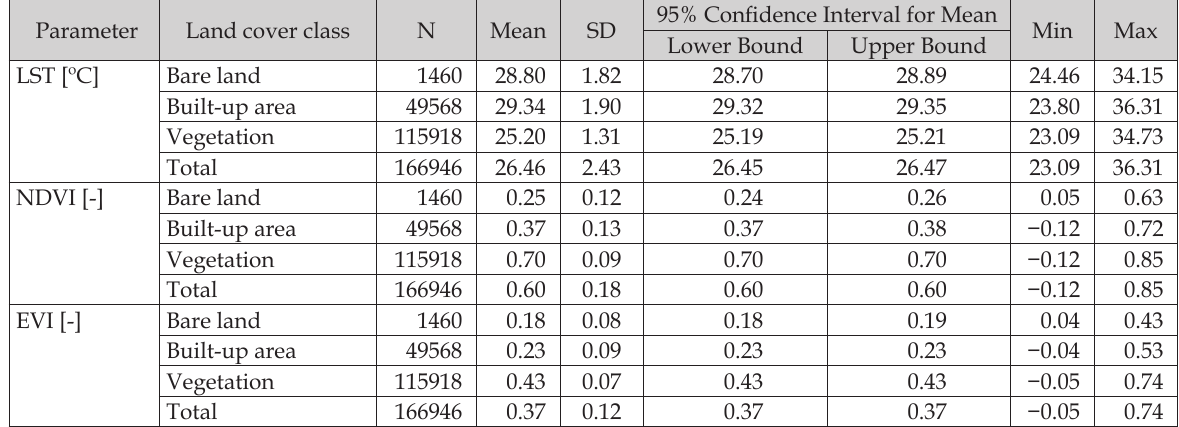
Table 8. Descriptive statistics of the LST, NDVI and EVI relationship with land cover in 2019.